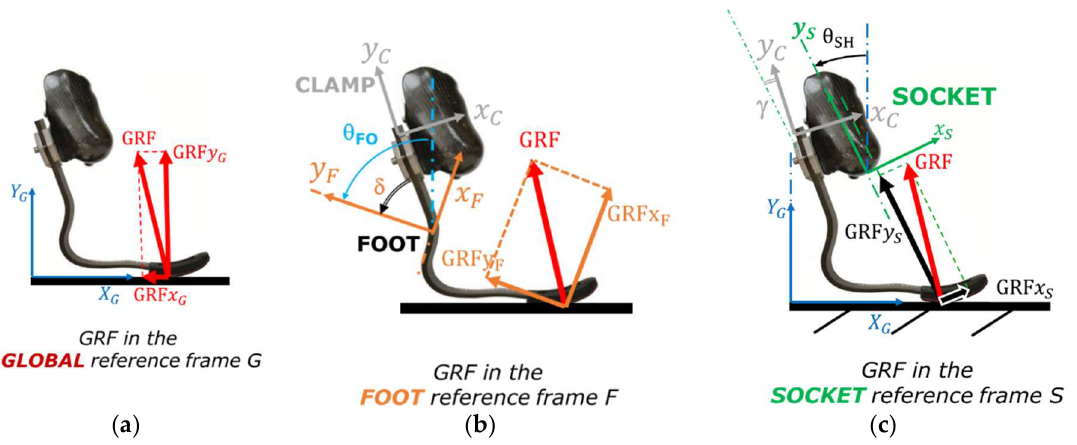
Figure 1. Reference Systems adopted to express the ground reaction forces (GRF) components for a transtibial amputation (TT) running specific prostheses (RSP). ( a ) Global reference system and GRF components, ( b ) Foot and Clamp reference systems with GRF components in the Foot reference system, and ( c ) Socket reference system and GRF components.